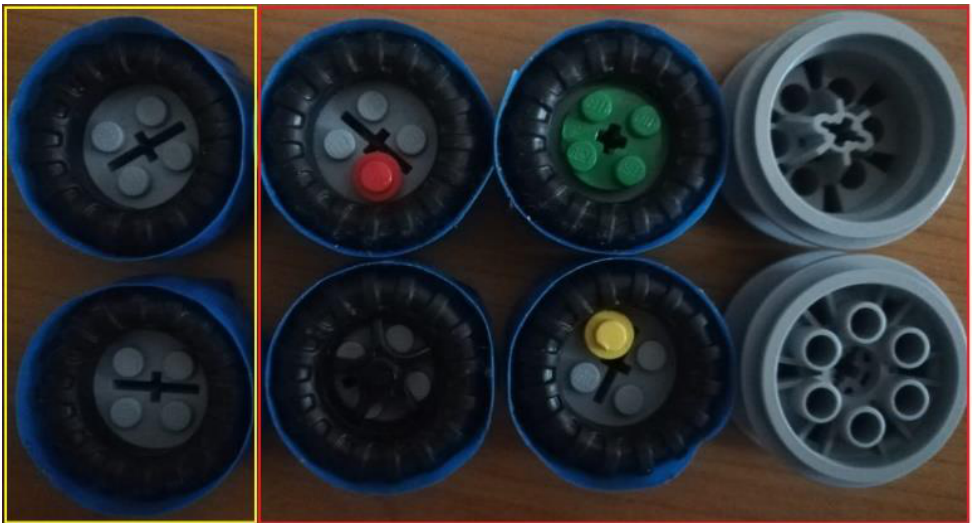
Figure 10. Products for the second task: desired state — yellow rectangle, undesired state — red rectangle.